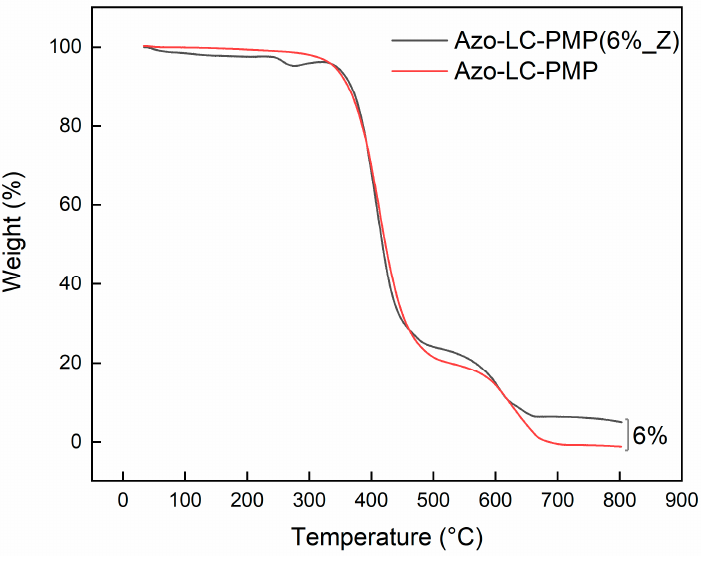
Figure 7. Thermogravimetric analysis of bare and doped PMP film, showing the degradation as a function of the